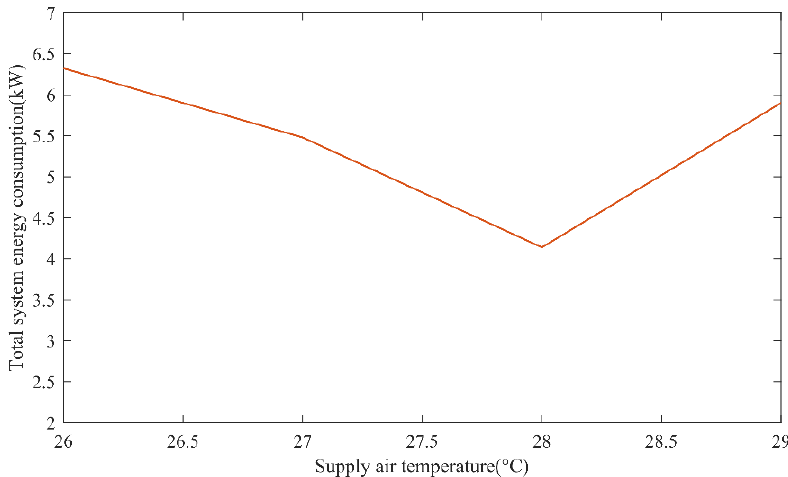
Figure 14. Relationship between total system energy consumption and supply air temperature in winter condition.